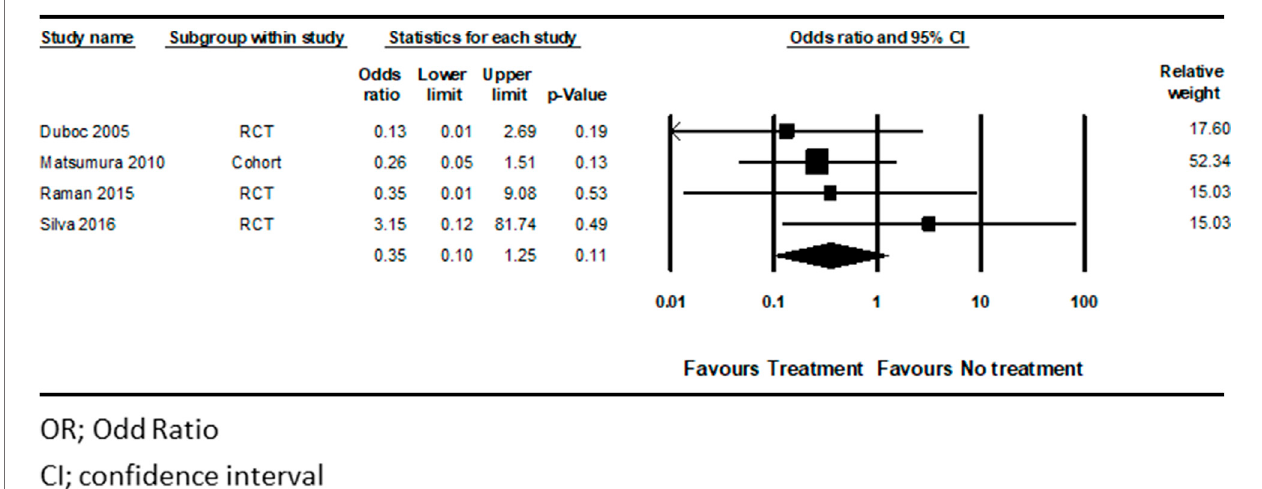
FIGURE 4 | The Odd Ratio for mortality following HF treatment versus